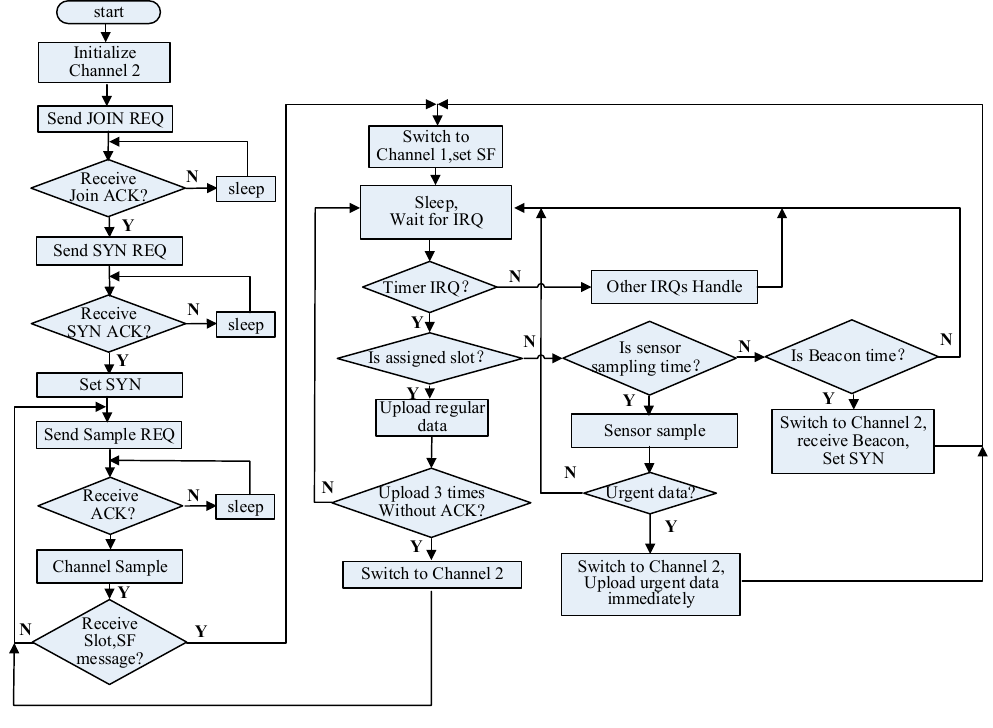
Figure 12. The flowchart of DMSF–TDMA for the end-node.